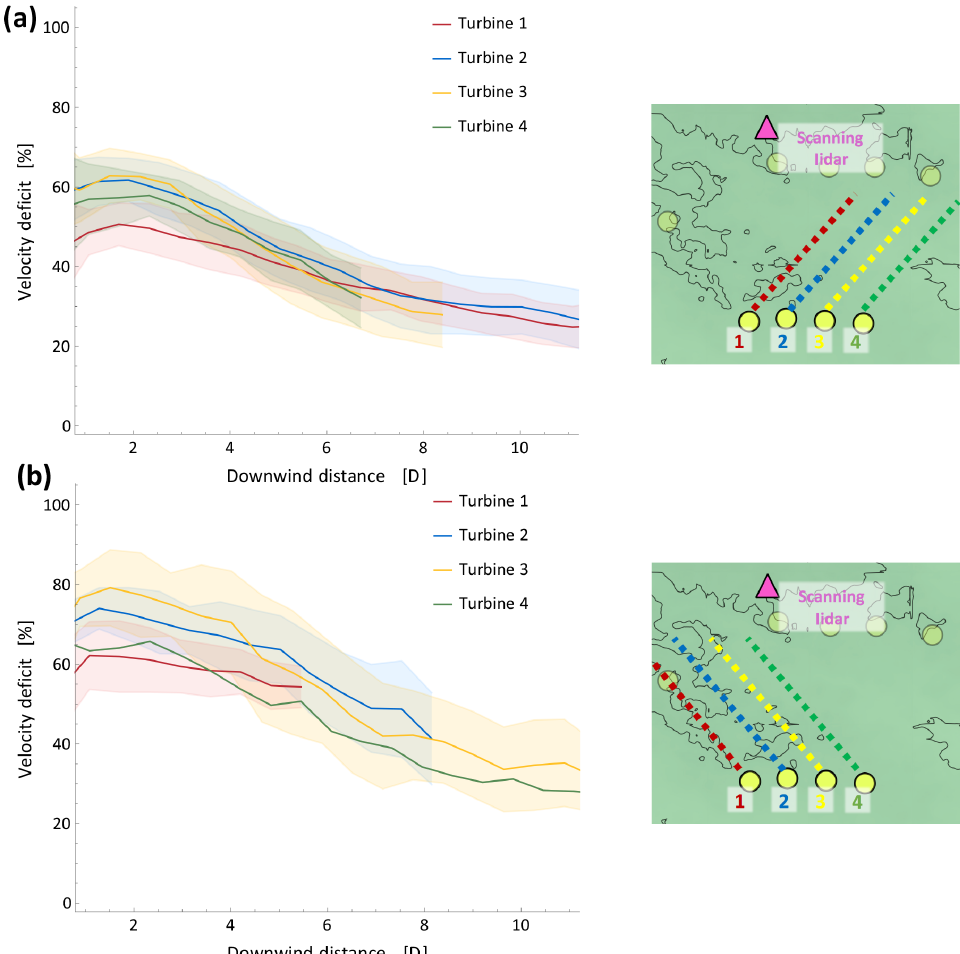
Figure 8. Velocity deficit vs. downwind distance, for the four wakes of the studied row of turbines. Continuous lines represent the median values calculated from the PPI scans performed at all the considered elevation angles during the night (stable conditions) of 26 (a) and 23 (b) August 2013; shaded areas show ± 1 standard deviation of the